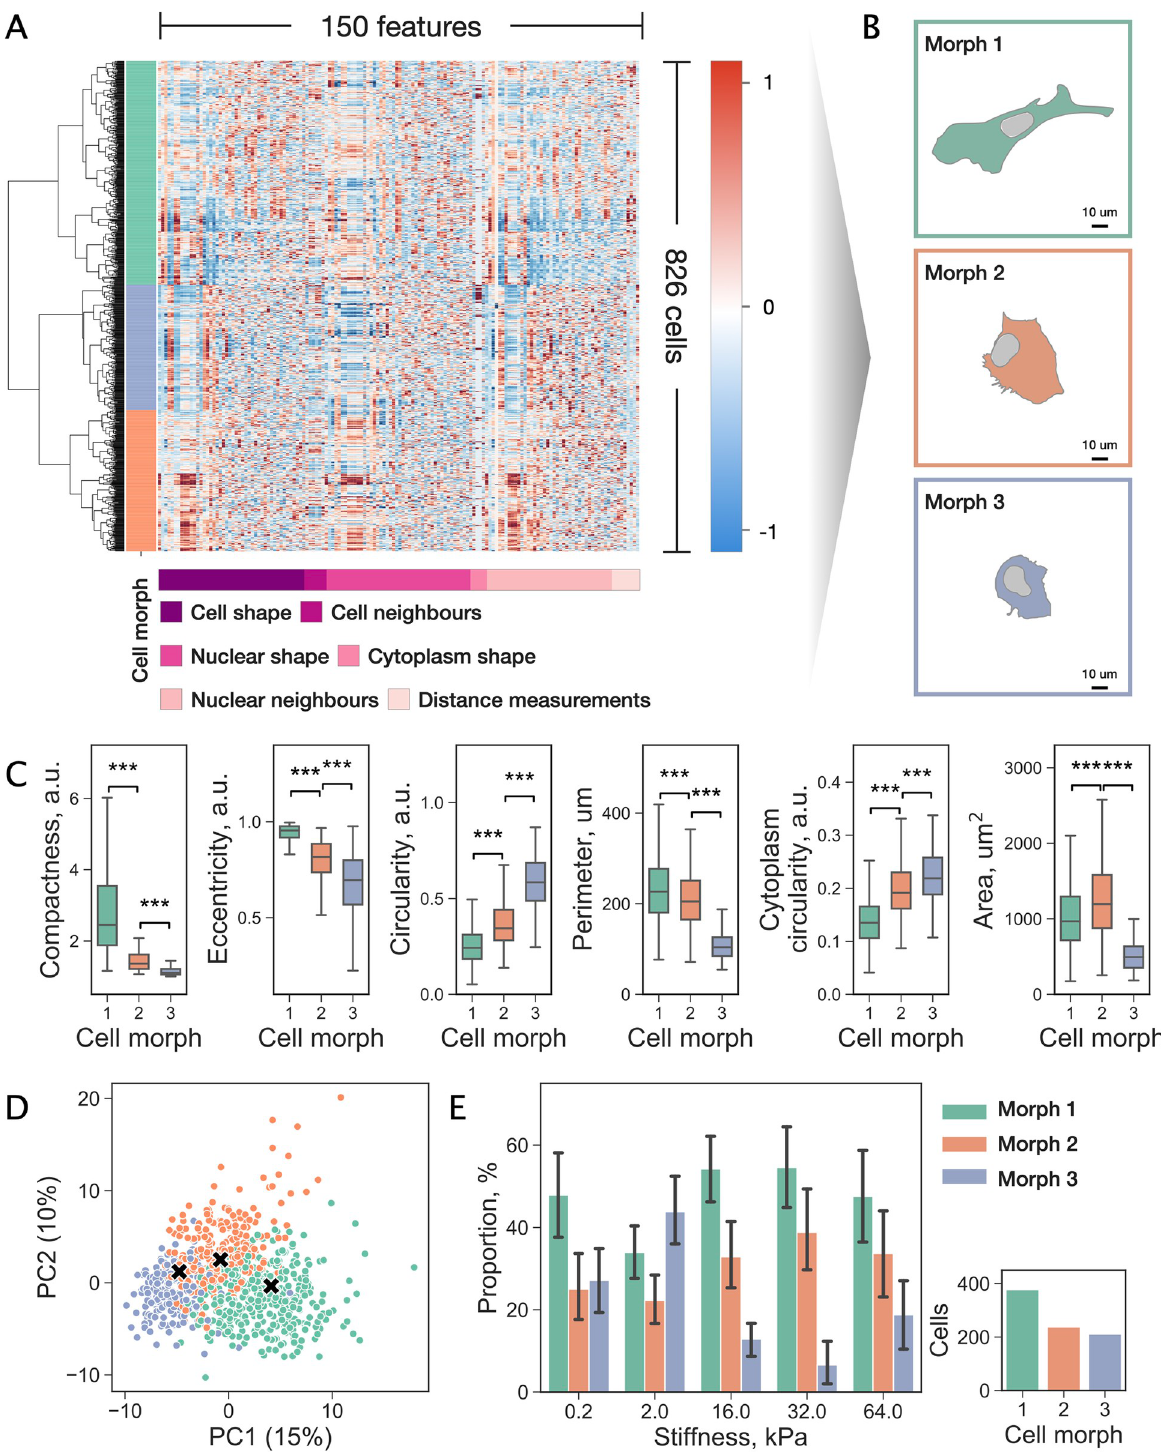
Fig 4. Identification of cell morphs using machine learning. (a) The results of HC applied to 826 cells based on similarities between single-cell profiles consisting of 150 morphological and contextual features. Left column indicates three cell morphs (green, blue, and red) identified in the total population of cells. Each row of the heatmap corresponds to a single cell and each column represents a single feature. Subgroups of features are depicted on the bottom. (b) Representative objects (medoids) of each of the three identified cell groups. (c) Top six features ranked by their contribution towards cluster separation. Distributions of the values are reported using box plots: a box shows the median value, first and third